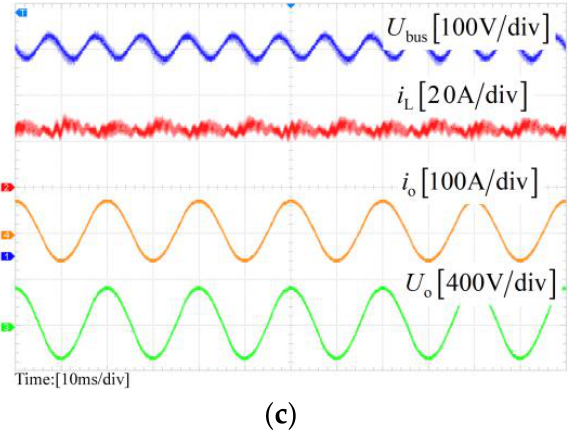
Figure 15. Steady-state experimental results. ( a ) Scheme I; ( b ) scheme II; ( c ) proposed NICFPS.